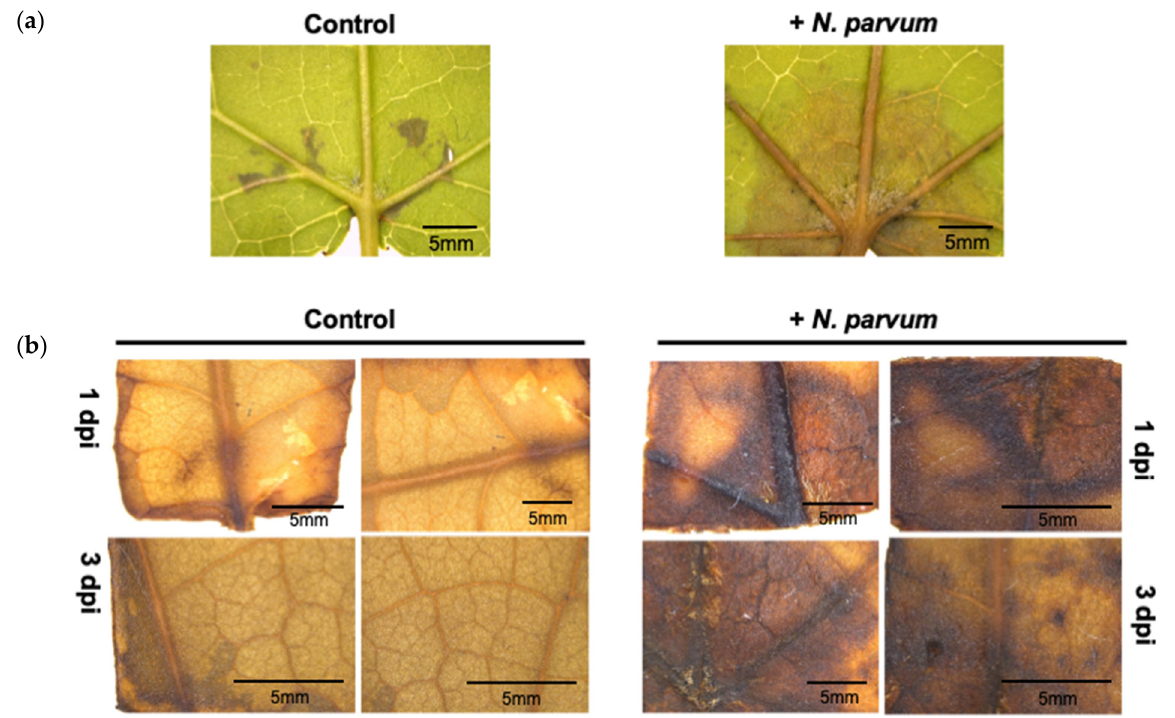
Figure 3. DAB staining of L. styraciflua leaves infected with N. parvum at early stages of infection. ( a ) Symptoms in leaves at 3 dpi. ( b ) V H 2 O 2 detection by DAB staining in infected and non-infected (control) leaves. Representative images of DAB stained leaves are shown. A stereomicroscope was used to acquire the images.